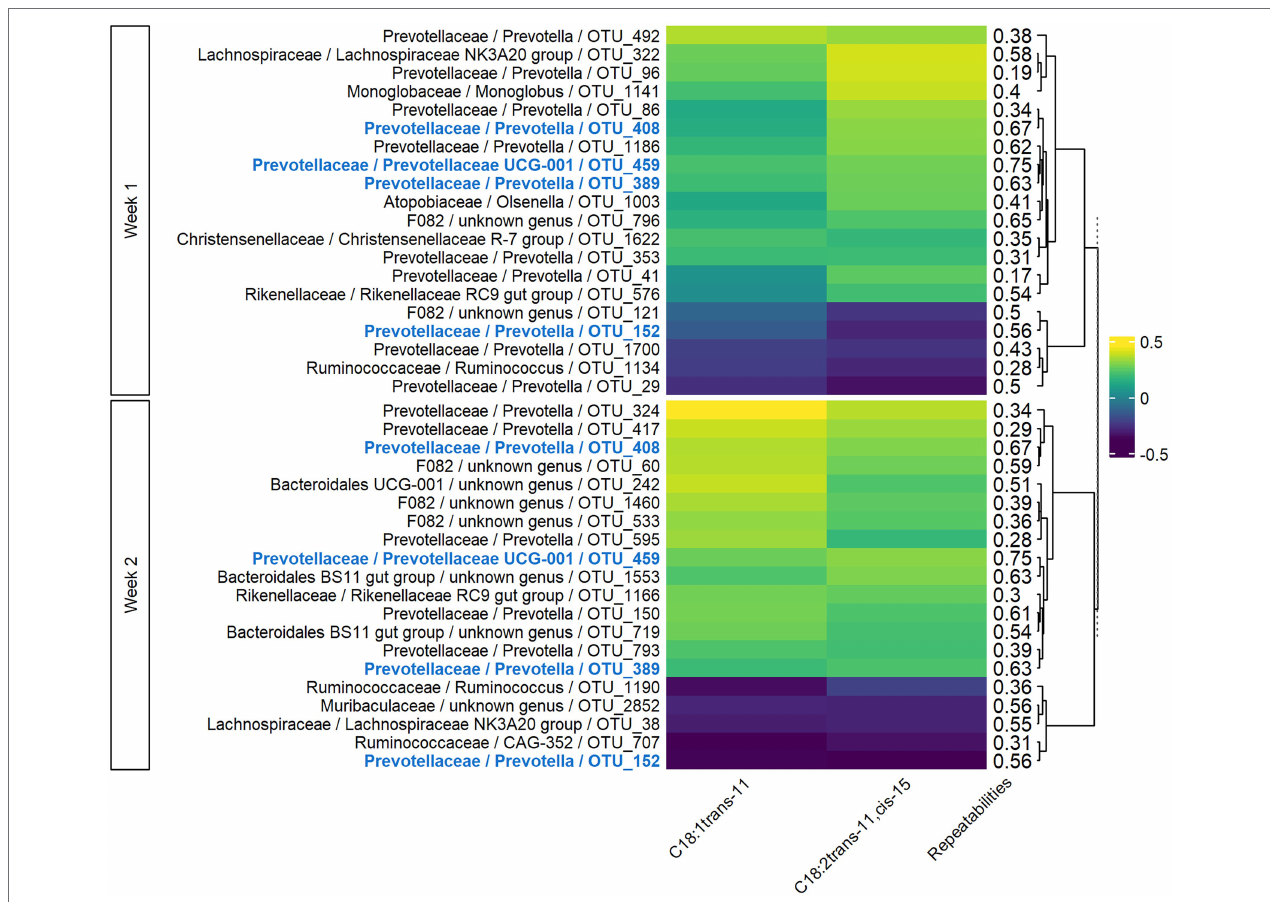
FIGURE 5 | Pearson correlations between bacterial OTUs and milk long-chain fatty acids on both weeks of sampling. Only the 20 more correlated OTUs and the milk LCFAs having at least one significant correlation in both weeks with them were presented. In bold and blue, OTUs conserved from week 1 to week